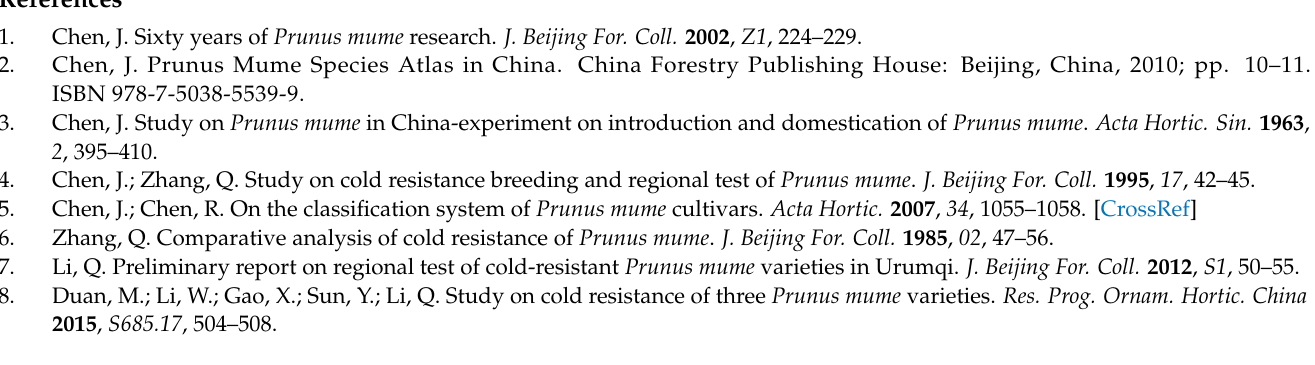
Figure S3: Dynamic video of three P. mume varieties freezing exothermic process. Figure S4: Dynamic video of P. mume stems freezing exothermic process. Figure S5: Dynamic video of P. mume flowerbuds freezing exothermic process. Table S1: Primer sequences for RT-qPCR in P. mume